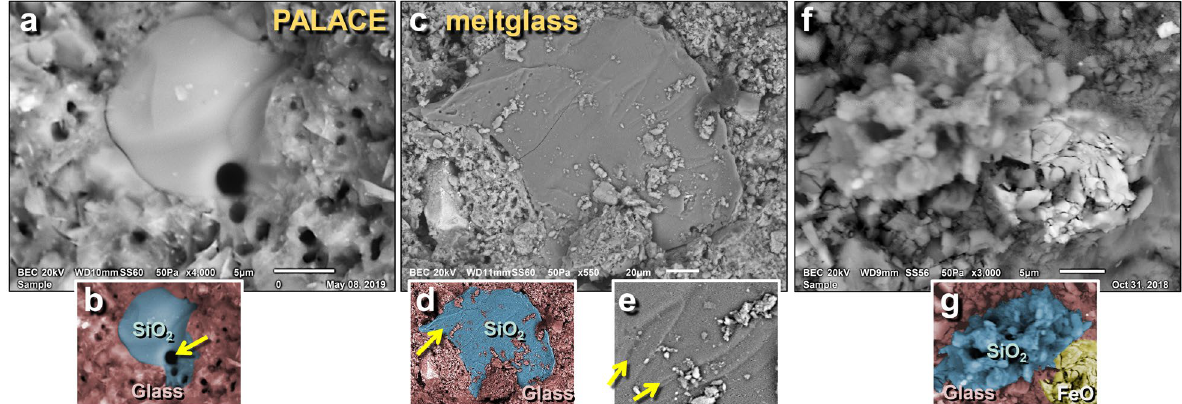
Figure 23. SEM images of melted quartz grains on melted mudbrick from the palace. ( a ) Highly melted quartz grain; ( b ) manually constructed EDS-based phase map indicates center is pure SiO 2 surrounded by melted mudbrick. Arrow points to vesicles indicating outgassing as grain temperature rose above ~ 1713 °C, the melting point of quartz. ( c ) The surface of a flattened quartz grain showing flow marks toward the upper right. High temperatures are required to lower the viscosity sufficiently for quartz to flow. ( d ) Manually constructed EDS-based phase map with an arrow pointing to vesicles indicating outgassing at high temperatures. ( e ) Close up of grain in panel ‘ c ’ showing flow marks (schlieren) at arrows. ( f ) Shattered, melted quartz splattered onto mudbrick meltglass; ( g ) manually constructed EDS-based phase map indicating that the blue area is SiO 2 ; the yellow area is a shattered, thermally altered Fe-oxide